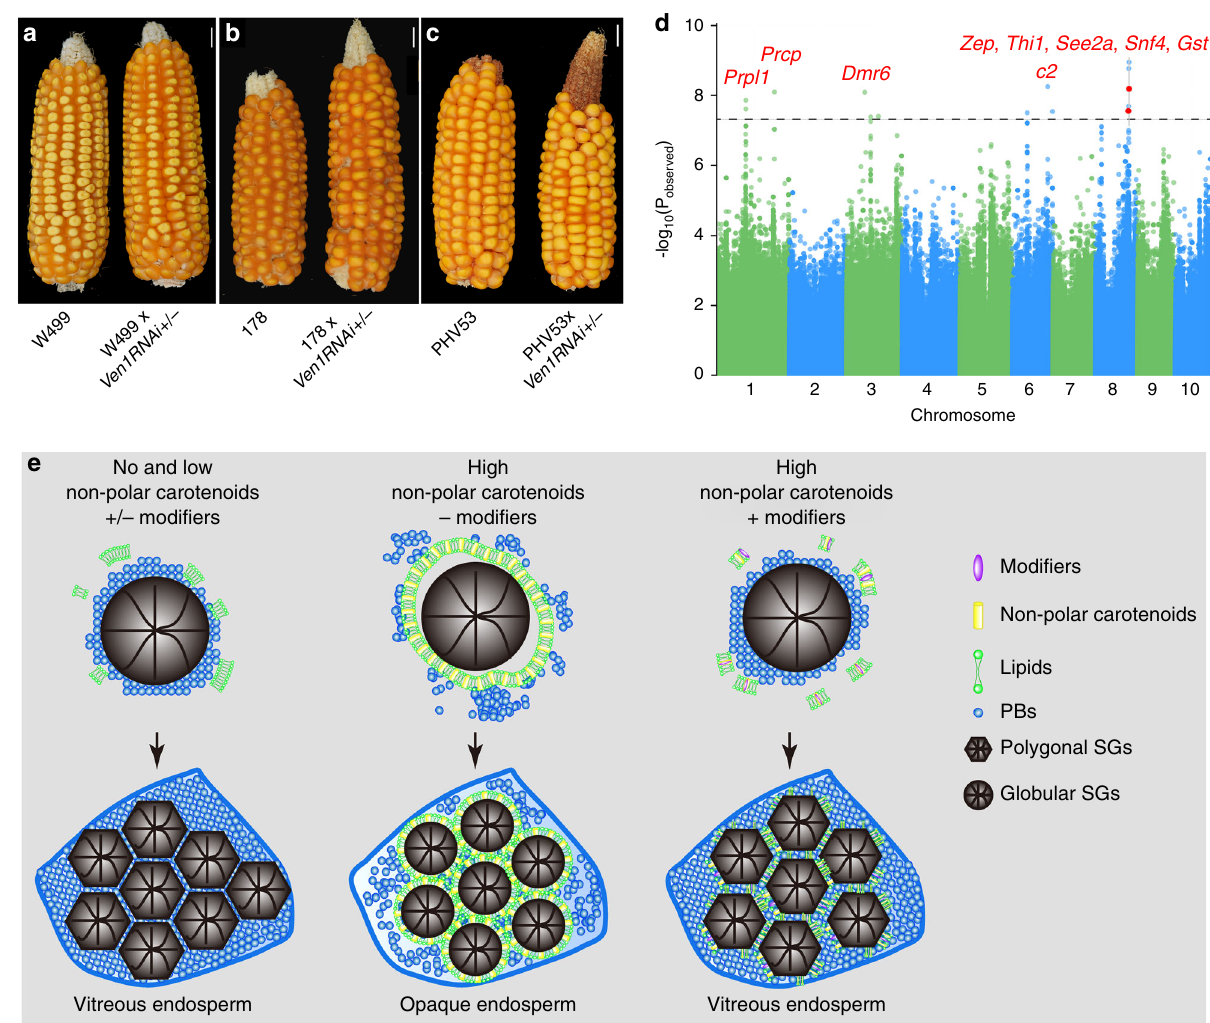
Fig. 5 Screening Ven1 A619 endosperm modi fi ers by GWAS and proposed model for vitreous endosperm formation. a – c Representative ear phenotypes showing full modi fi cation ( a ), partial modi fi cation ( b ) and totally unmodi fi ed ( c ) pollinated by Ven1RNAi/ + . d Manhattan plot of whether the endosperm contains Ven1 A619 modi fi ers. The dashed line indicates the signi fi cance threshold of P -value 5 × 10 − 8 . 27 unique SNPs are labelled with red dots, and the candidate genes are highlighted. The numbers on the horizontal axis indicate the maize chromosomes. e Proposed model for vitreous endosperm